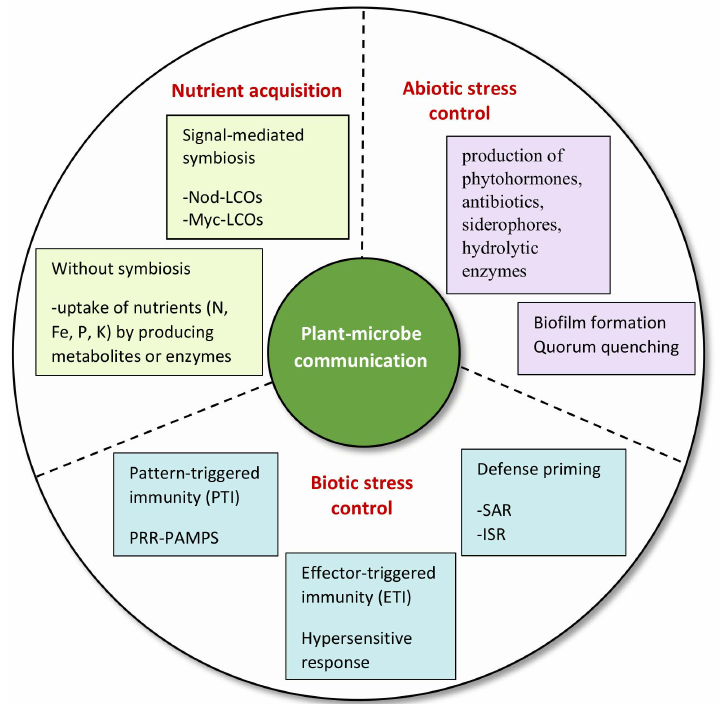
Figure 4. Summary of significant factors of rhizosphere signaling. SAR, systemic acquired resis- tance; ISR, induced systemic resistance; LCOs, lipo-chitooligosaccharides; Nod, nodulation; Myc, mycorrhizal; PRR, pattern recognition receptor; PAMPs, pathogen-associated molecular